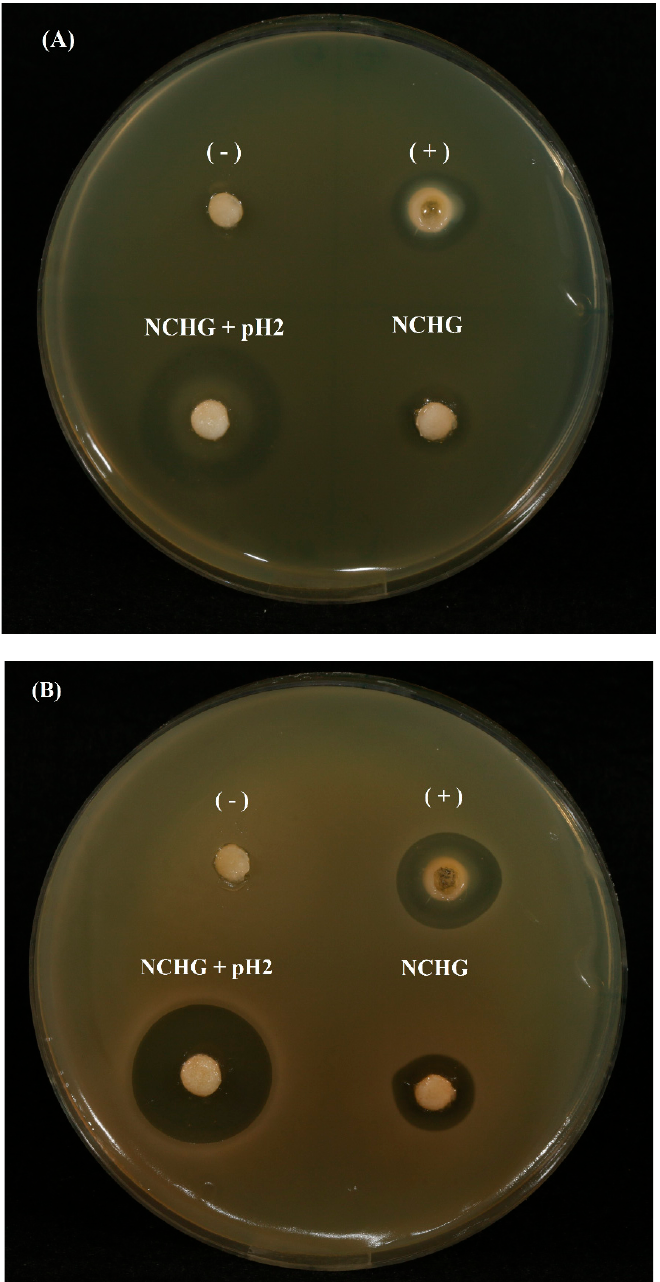
Figure 12. Antibiotic effect of CHX/metronidazole-filled hydrogels: NCHG samples without drugs ( − ); metronidazole/CHX solution was used as a positive control (+); CHX/metronidazole containing NCHGs were investigated with distilled water (down on the right side), and with pH 2 buffer solution (down and on the left side). ( A ) Picture shows the results at the 4th hour, and the ( B ) image represents the 24 h effects. Samples were placed into agar plates inoculated with E. coli K12 ER2738 for the study of antibiotic effect.